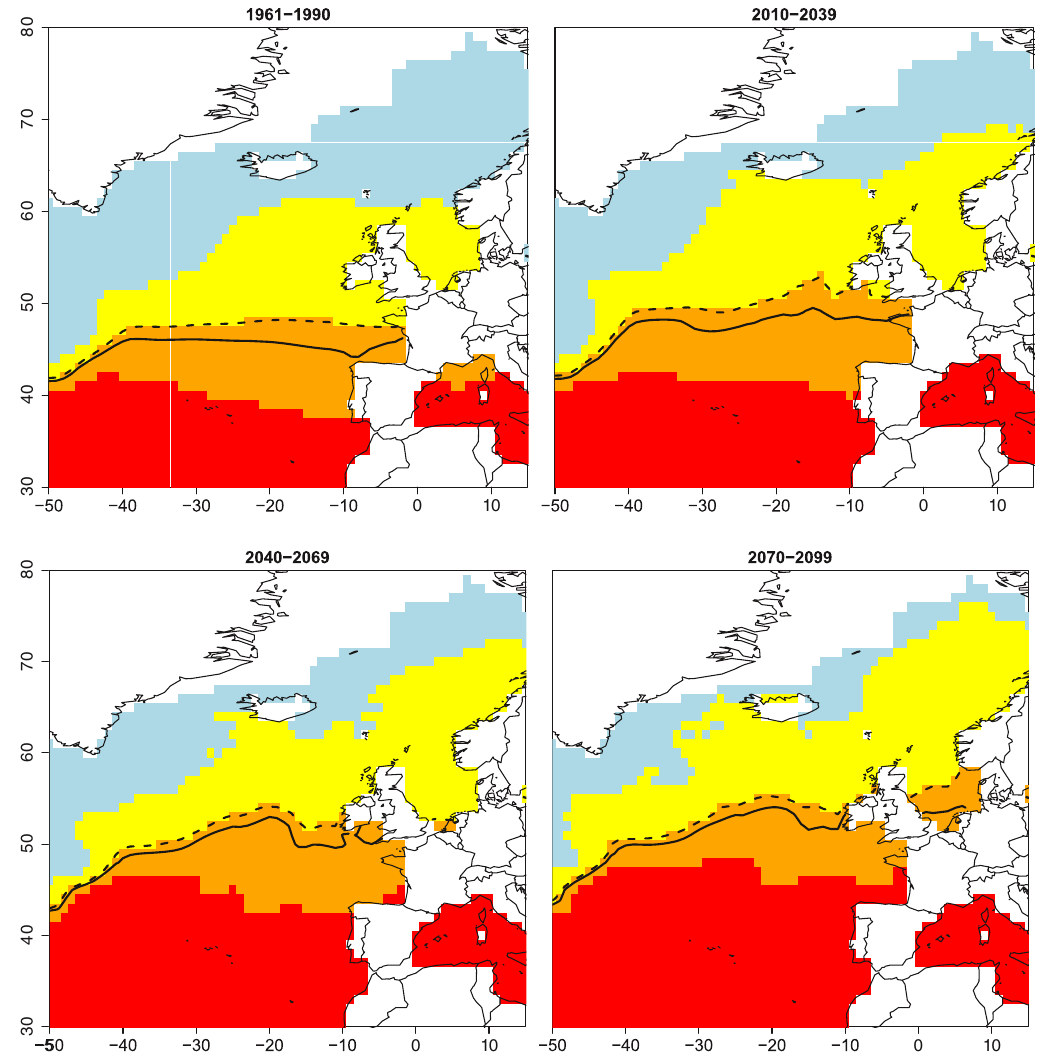
Fig. 6 IPCC-based modelling of climate driven shifts in beta diversity breakpoints. Observations (1961 – 1990) and modelled (2010 – 2099) changes over the 21st century, in the thresholds for breakpoints in beta diversity. Regions are shown as red for metatranscriptomes (>18.06 °C), orange for 18S (<18.06 °C, >13.96°C), yellow for 16S (<13.96 °C, >9.49°C) and blue for temperatures <9.49 °C for a 1961 – 1990 observations from the HadISST dataset. Modelled estimates temperatures from the HadGEM2-ES CMIP5 run for the 30-year averages, 2010 – 2039, 2040 – 2069, and 2070 – 2099, respectively. Temperatures from HadGEM2-ES have been calibrated to the HadISST observations as described in methods. Black solid line represents the 15 °C and the dashed line the 14 °C average upper ocean